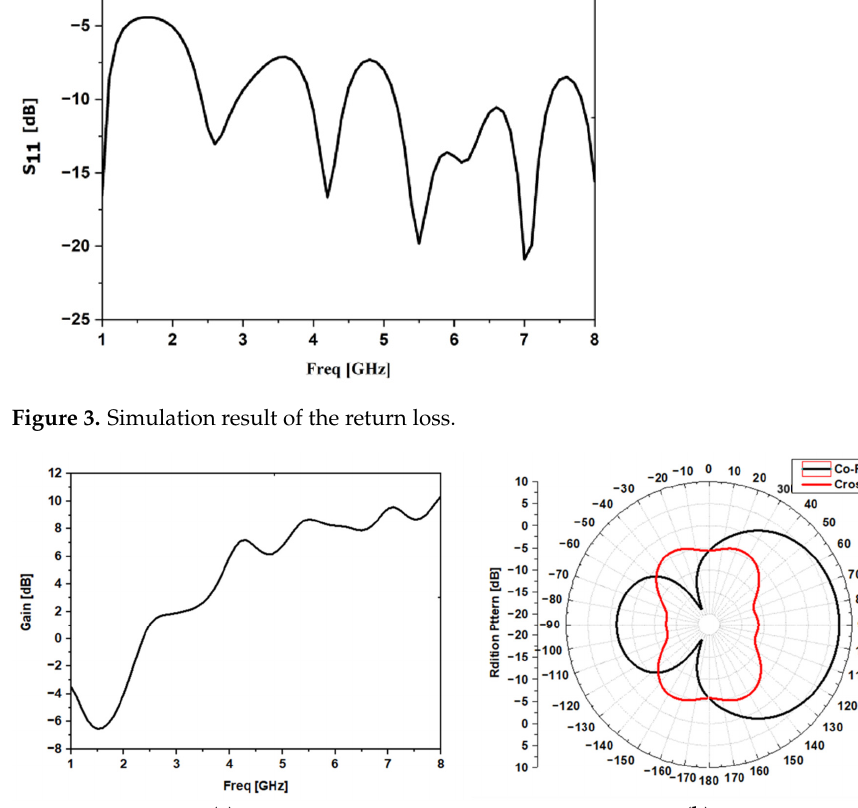
2.2. The Proposed Metamaterial Antipodal Vivaldi Antenna (MTM-AVA) This section describes the design of the MTM unit and how to improve the charac- teristics of the antenna to reduce its size, finishing with a presentation of the miniaturized AVA based on the MTM units. 2.2.1. Metamaterial Structure Figure 5a presents the schematic MTM geometry. It consists of a resonator, an E- shape and teeth printed on a Roger 3010 dielectric substrate with a permittivity of 10.2 and 0.64 mm of thickness. Generally, the metamaterials used in the 5 GHz frequency have large dimensions, such as in [9]. The designed resonators are split ring resonators at 2.45, and 5 GHz is 34 × 34 mm 2 , which inspired this model. The unit cell size of the proposed metamaterial is 0.058 λ × 0.054 λ (3.25 × 3.25 mm 2 ) at the operation frequency of 5 GHz. Figure 5b presents the setup simulation box of the proposed MTM using the Computer Simulation Technology-Microwave Studio Suite (CST-MWS) based on the time − domain method. As indicated in the figure, the proposed MTM was placed inside a waveguide with perfect magnetic conductors (PEM) on its top and bottom, perfect electric conductors (PEC) on its two side walls and two waveguide ports for excitation (Port 1 and Port 2).